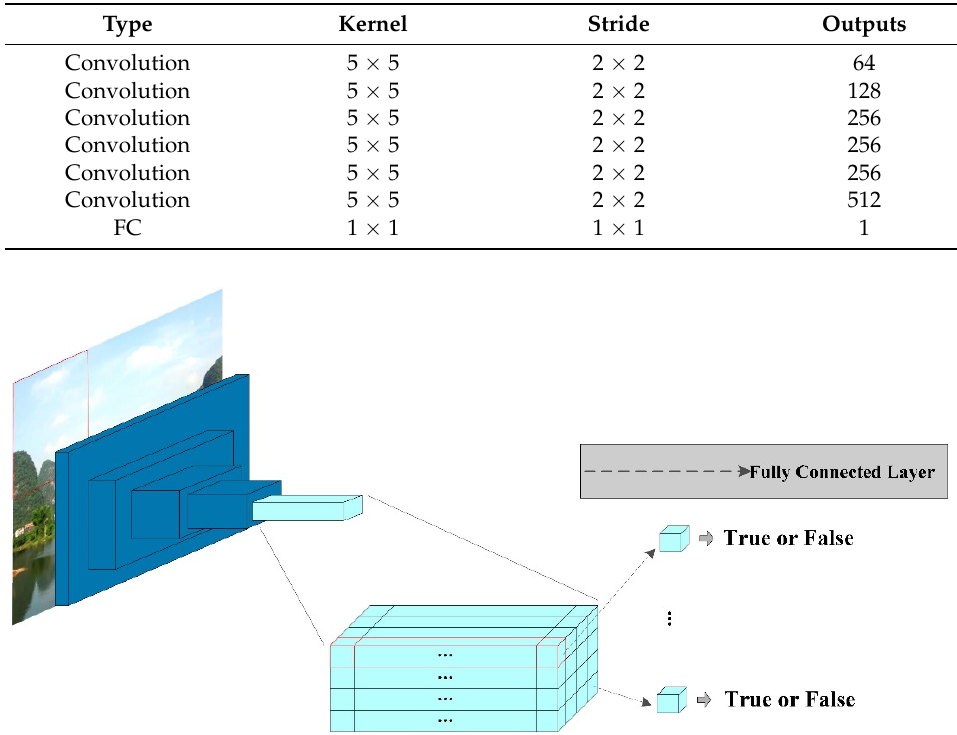
Table 3. Detailed structure of regional integration discriminator model.